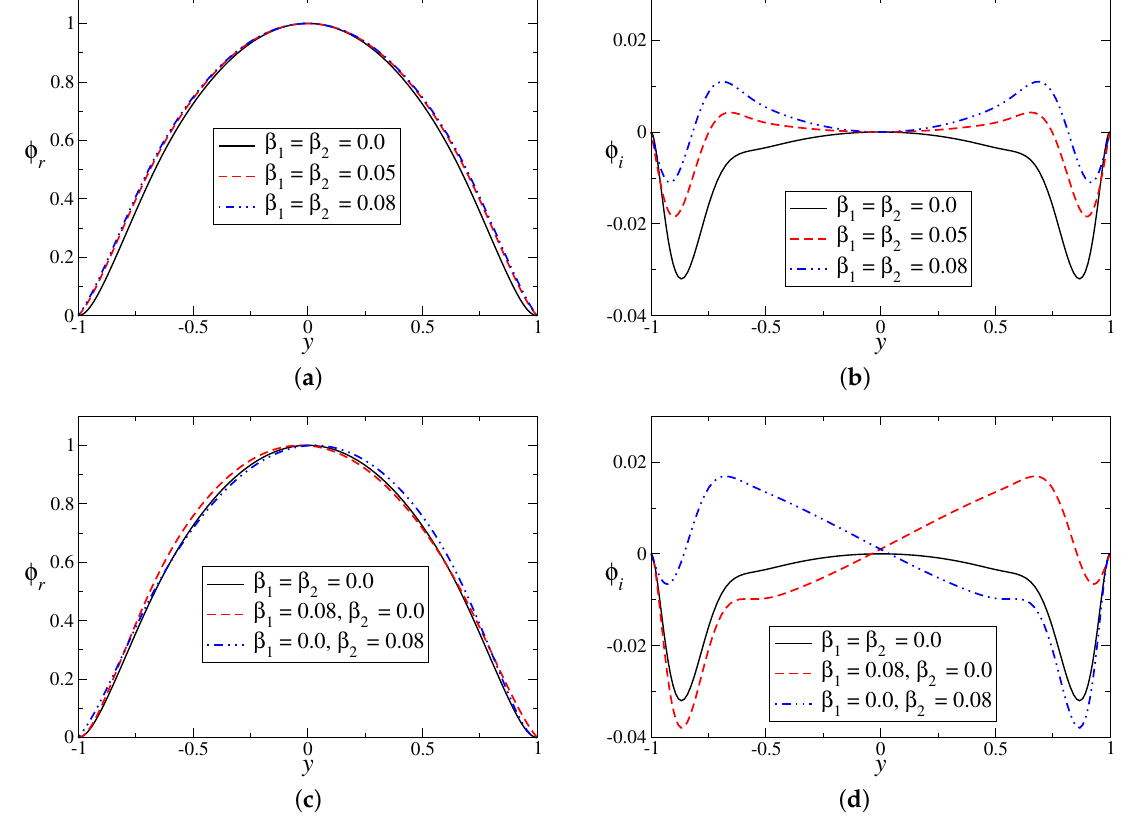
Figure 12. Eigenfunctions for σ 1 = 0, σ 2 = 0.2 and Re = 1000: ( a , b ) Symmetric slip ( β 1 = β 2 ); and ( c , d ) non-symmetric slip ( β 1 (cid:54) = β 2 ). The subscripts r and i represent the real and imaginary parts of the eigenfunction φ